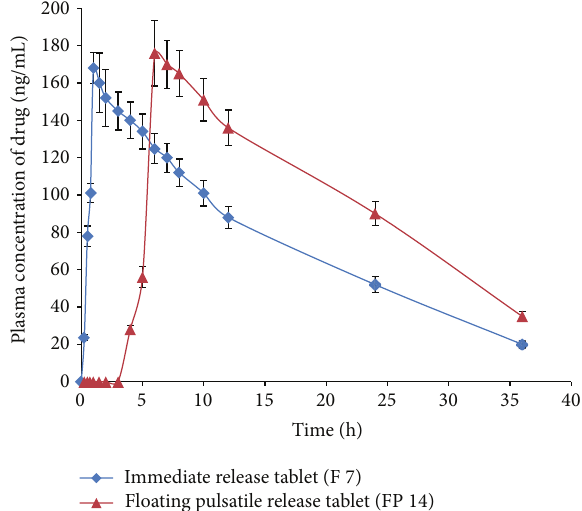
Figure 9: Plasma drug concentration-time curves for pharmacoki- neticstudyinrabbits.Allpointsarepresentedasmean ± SEM, 𝑛 = 3